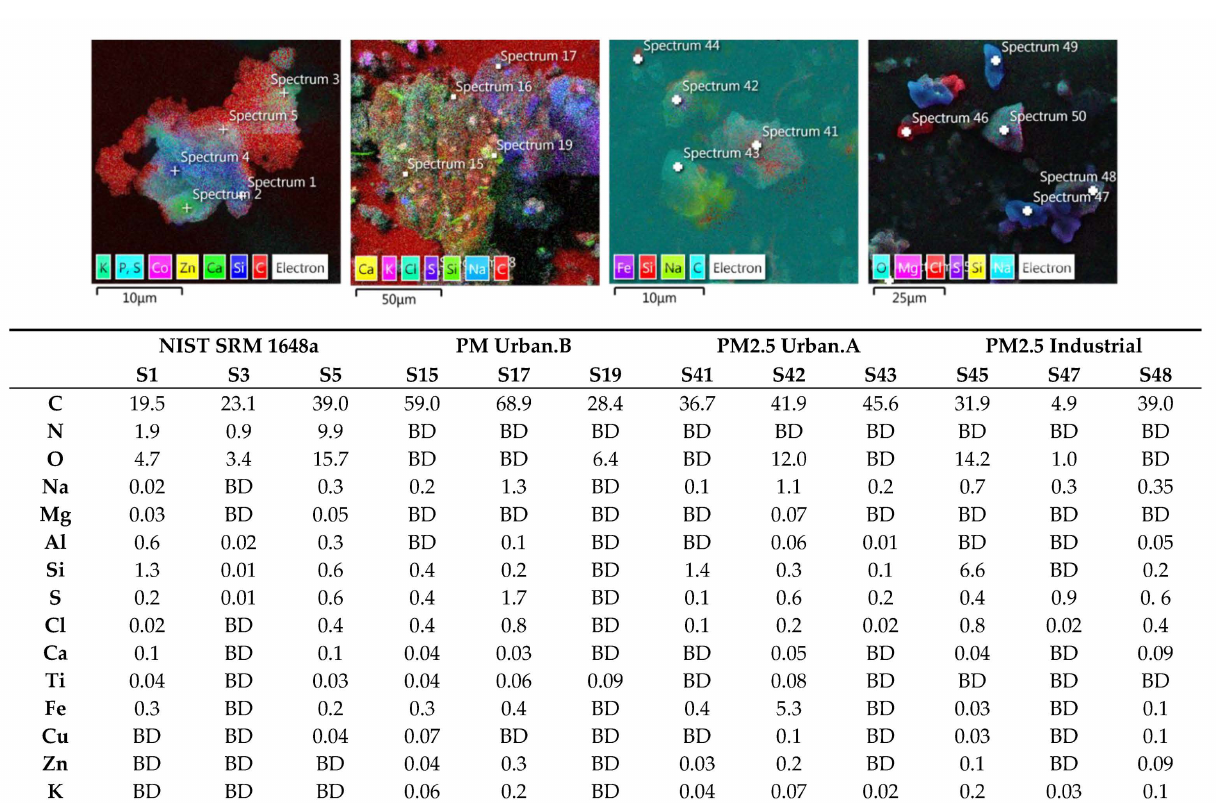
Figure 4. Energy dispersive spectroscopy mapping of PM samples and contents of selected elements (in wt%) of Krak ó w PM samples determined by EDS analysis. BD—below the detection